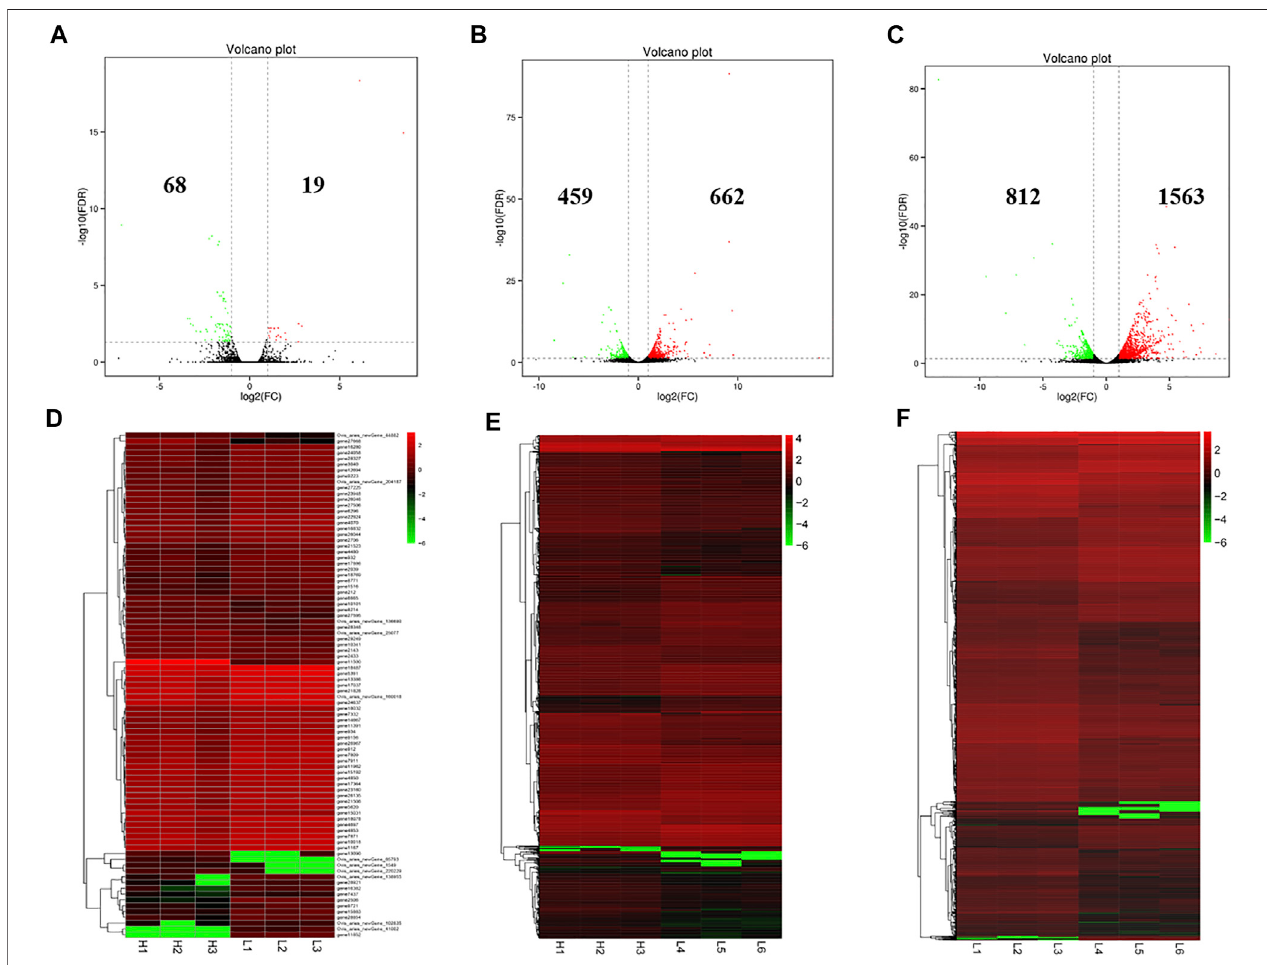
FIGURE 4 | Identi fi cation of DE mRNAs. (A – C) Volcano plot of DE mRNAs in each group. Red indicates up-regulation and green indicates down-regulation. (D – F) Hierarchical clustering of DE mRNAs in each group. (A,D) : LPBB vs. HPBB; (B and E): LPB + vs. HPBB; and (C,F) : LPB + vs. LPBB groups. HPBB (H1, H2, H3); LPBB (L1, L2, L3); LPB+ (L4, L5,